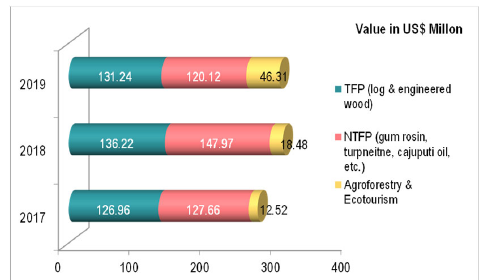
Fig. 3. Chart of Perhutani Revenue Stream by Line of Business fro 2017 to